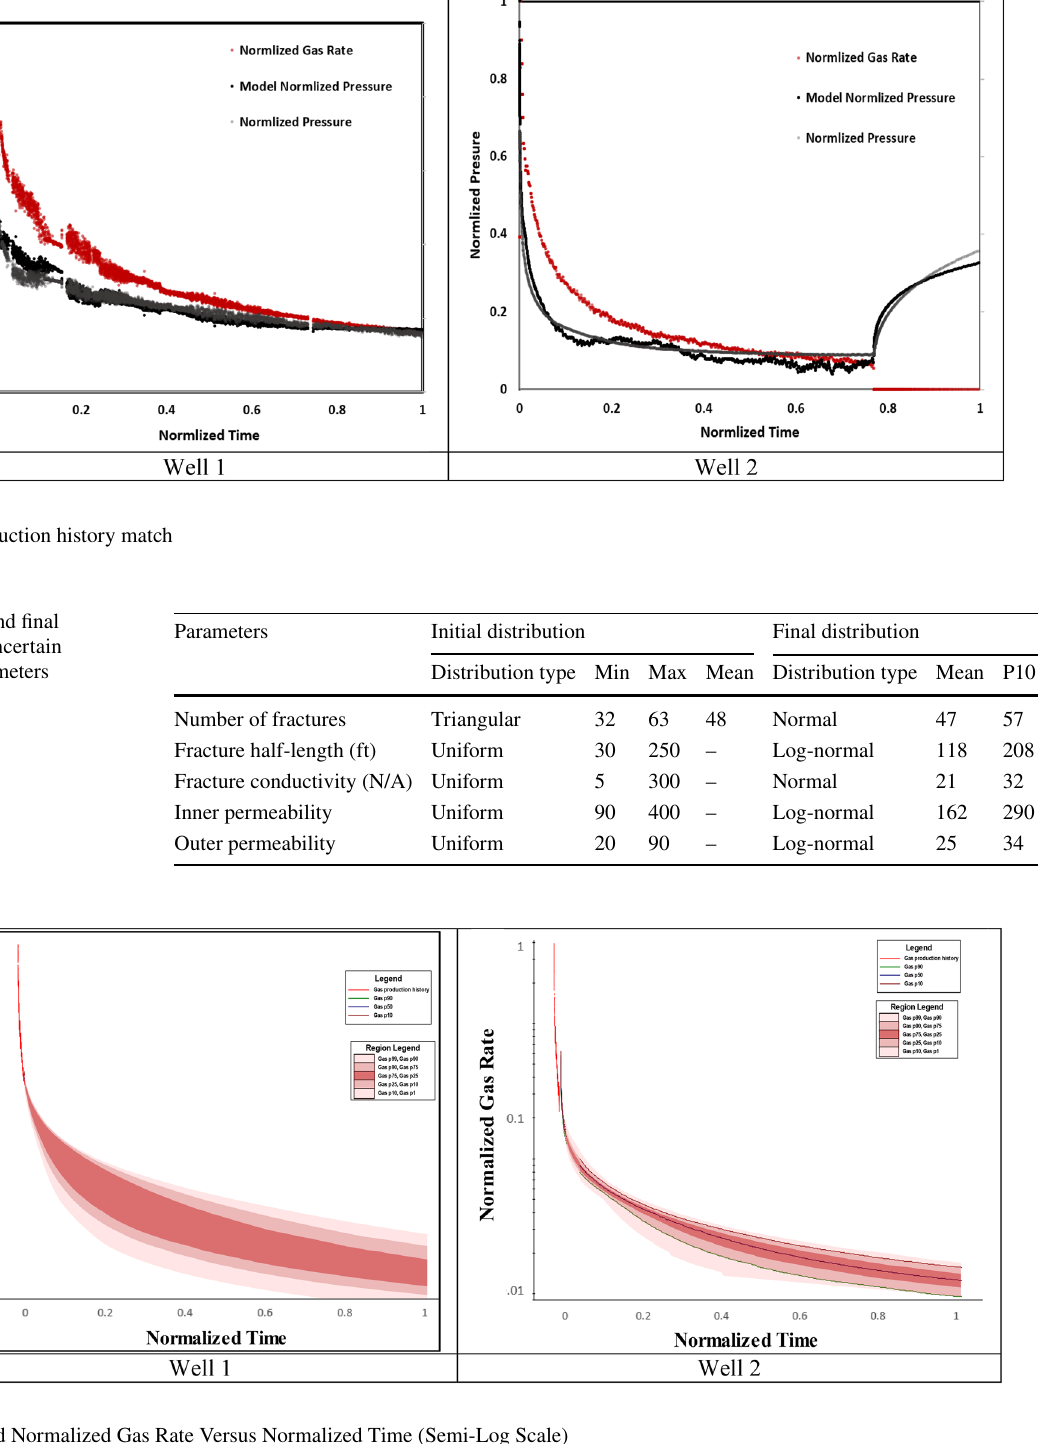
Fig. 7 Forecasted Normalized Gas Rate Versus Normalized Time (Semi-Log